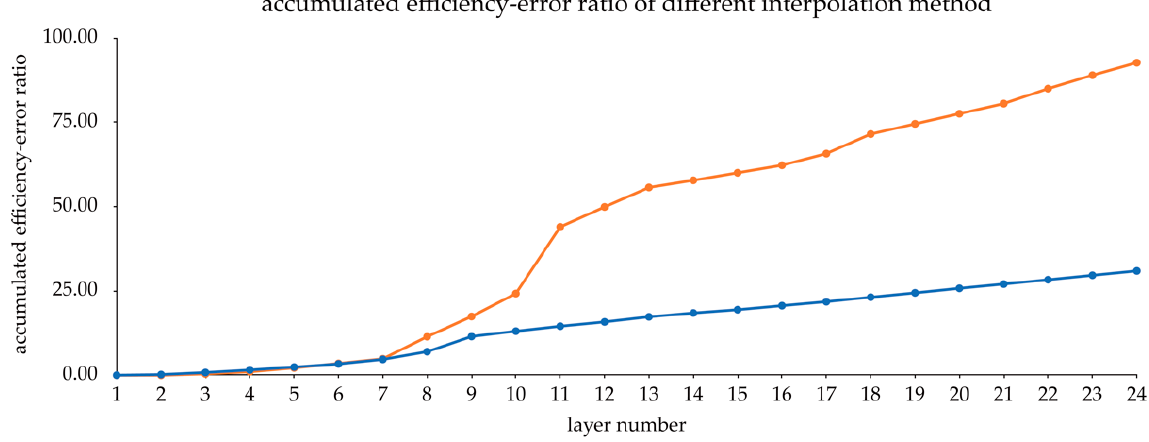
Figure 12. Accumulated efficiency-error ratio of different interpolation methods.